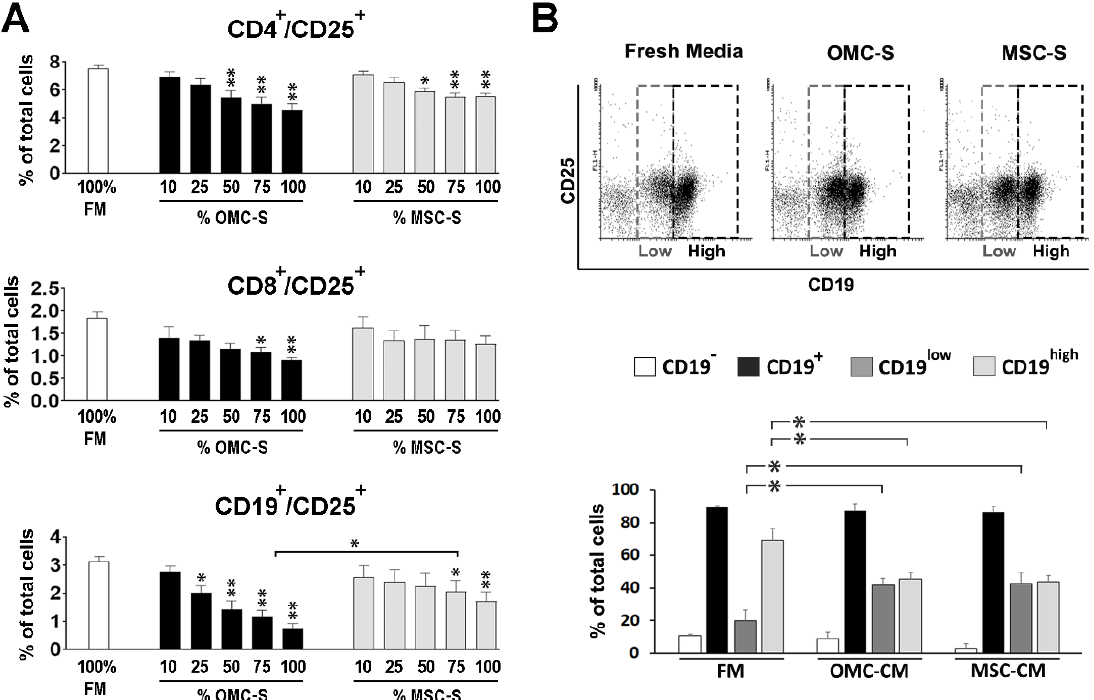
Figure 5. OMC-derived secretome inhibits the activation of lymph node T and B cells and peritoneal fluid B cells. ( A ) Quantification (% of total cells) of CD4 + /CD25 + and CD8 + /CD25 + activated T cells and CD19 + /CD25 + activated B cells within mouse lymph nodes (LN) cells cultured for 24 h in 100% fresh media supplemented with 25 µg/mL phytohemagglutinin (PHA) or increased proportions (10–100%) of OMC-S (ALIC1, SEV1, and SEV4) or MSC-S supplemented with PHA. Results are mean ± s.e.m from n = 4 independent experiments. Statistical differences between control (100% fresh media + PHA) and OMC-S and MSC-S conditions were calculated using ANOVA. Difference between 100% OMC-S and MSC-S for CD19 + /CD25 + B cells was calculated with Student’s t test. ( B ) OMC-derived secretome inhibits peritoneal fluid B cells. Upper, shows representative coexpression of CD19 and CD25 in non-adherent mouse peritoneal fluid cells (PFC) cultured for 72 h in either fresh media (FM), OMC-S, or MSC-S. Two rectangles delimiting CD19 low (grey rectangle) and CD19 high (dark rectangle) expressing B cells are shown. Lower graph shows flow cytometric quantification of CD19 − , CD19 + , CD19 low , and CD19 high populations within non-adherent PFC cultured for 72 h in either fresh media or OMC-S (ALIC1, SEV1, and SEV4) and MSC-S. Results are shown as mean ± s.e.m from n = 3 independent experiments. Statistical differences for CD19 low and CD19 high between different culture conditions groups were calculated using Student’s t test. ( A , B ) * for p ≤ 0.05; ** for p ≤ 0.01.